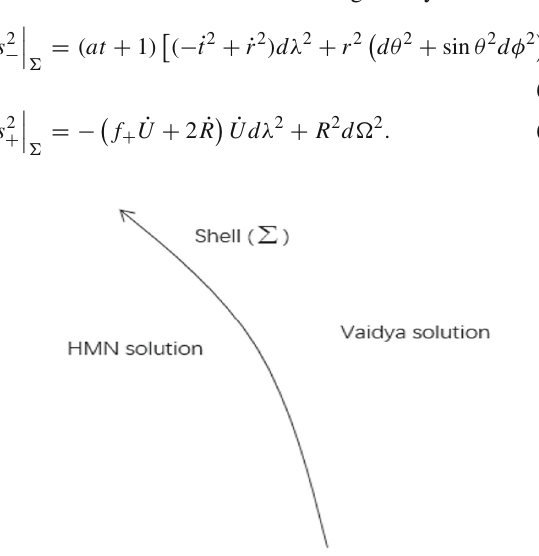
Fig. 6 The thin shell represented by a timelike